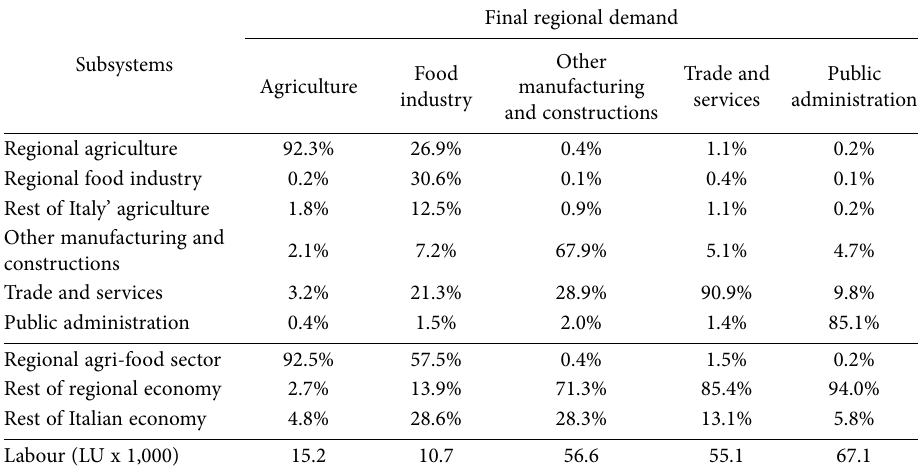
Table 5. Composition of subsystems in terms of employment: